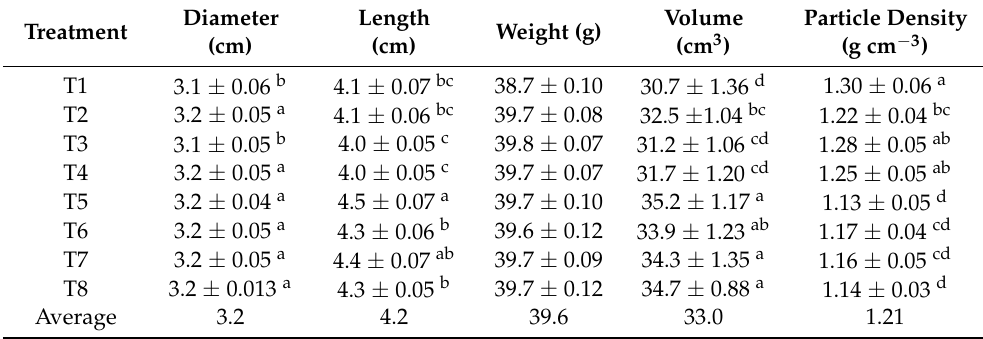
Table 4. Physical properties of briquettes in each moisture x pressure